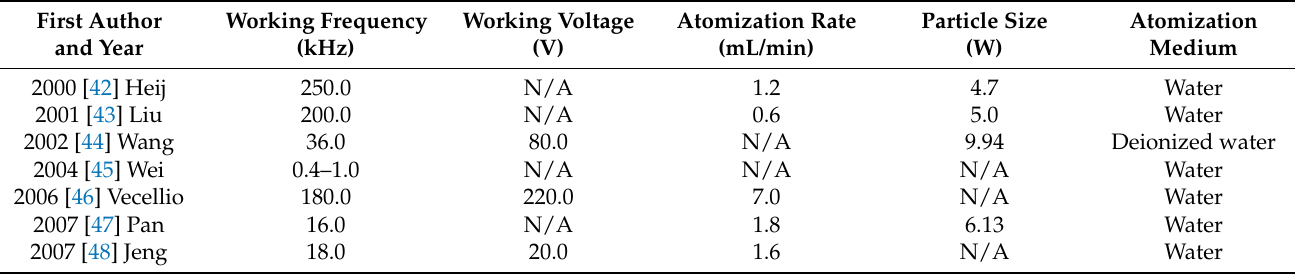
Table 2. Summary of properties for the static mesh